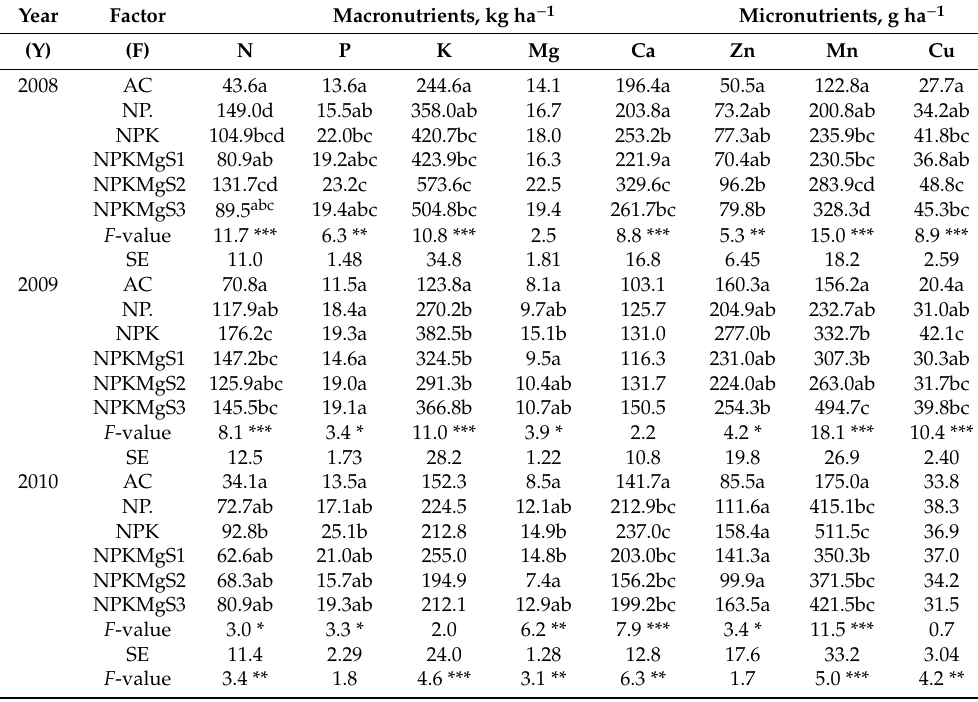
Table 5. Nutrient accumulation in WOSR post-harvest residues.